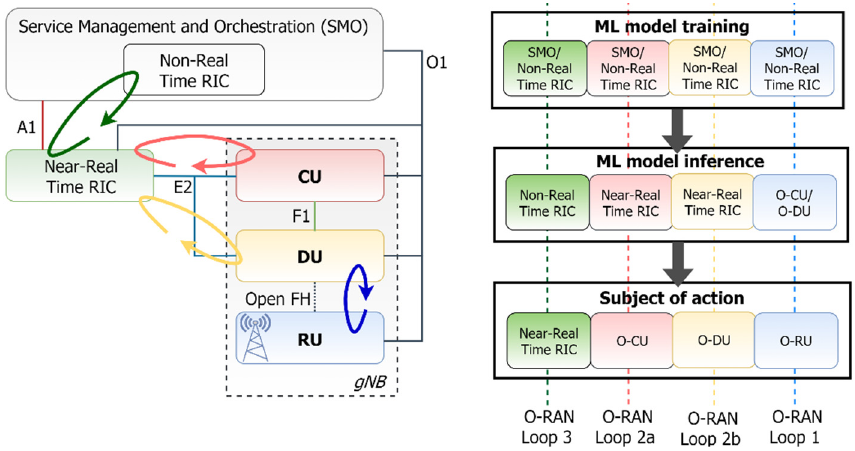
Figure 6. Matching the O-RAN architecture with the ML workflow ([43]).